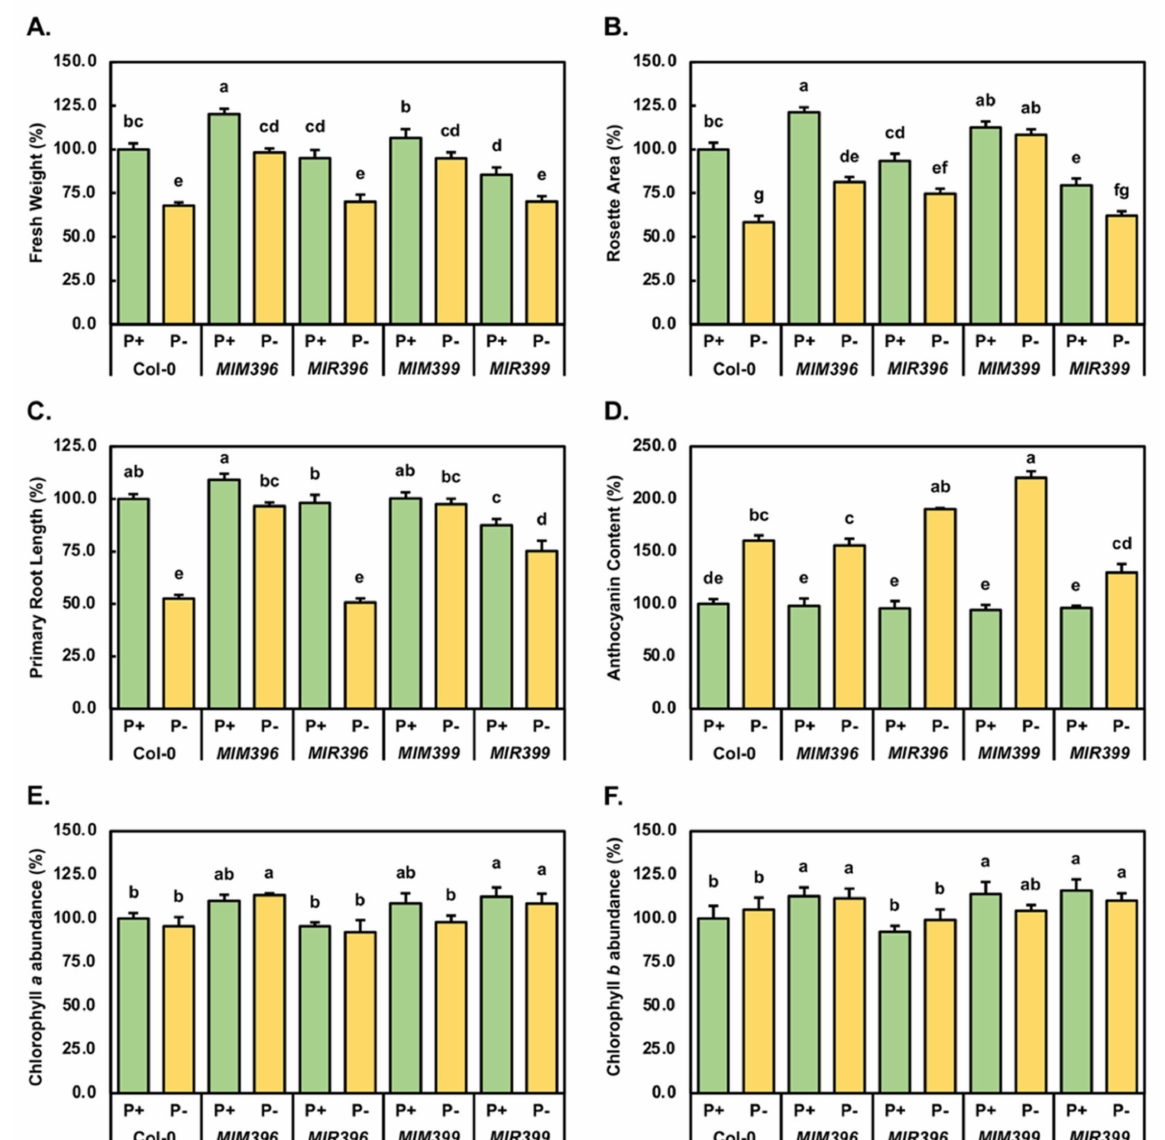
Figure 2. Phenotypic and physiological assessment of 15-day-old control-grown and PO 4 -starved Col-0, MIM396 , MIR396 , MIM399 and MIR399 seedlings. Quantification of the phenotypic parameters of ( A ) fresh weight (mg), ( B ) rosette area (mm 2 ) and ( C ) primary root length (mm) for control-grown and PO 4 -starved 15-day-old Col-0, MIM396 , MIR396 , MIM399 and MIR399 seedlings. Quantification of the physiological parameters of ( D ) anthocyanin content ( µ g/g FW), ( E ) chlorophyll a and ( F ) chlorophyll b abundance (mg/g FW), for control-grown and PO 4 -starved 15-day-old Col-0, MIM396 , MIR396 , MIM399 and MIR399 seedlings. All phenotypic and physiological metrics are presented as a percentage (%) post comparison to the respective values obtained for Col-0/P + plants which were assigned a value of 100% for each assessed growth charac- teristic. ( A – F ) Error bars represent the standard deviation of four biological replicates. The statistical data were analyzed with the use of the one-way ANOVA and Tukey’s post hoc tests and a statistically significant difference ( p -value < 0.05) is denoted by a different letter above a histogram